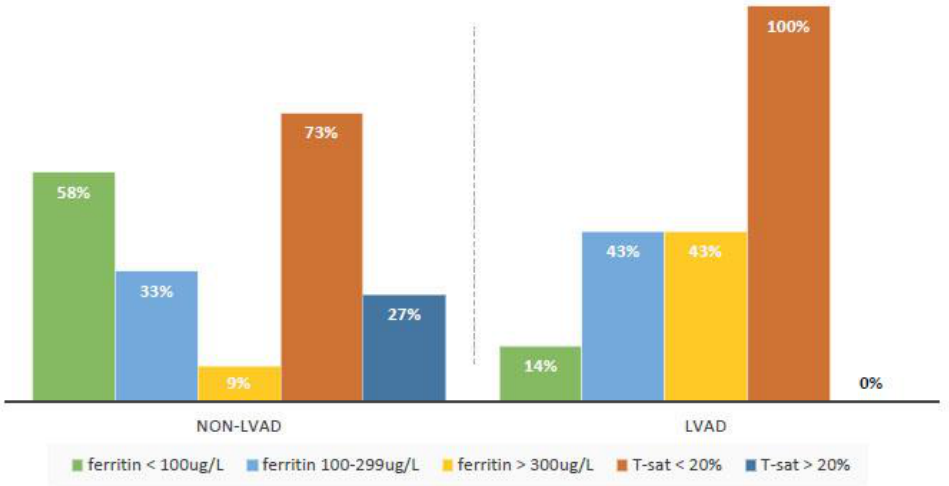
Figure 2. Percentage of iron deficiency parameters in non-LVAD and LVAD patients.